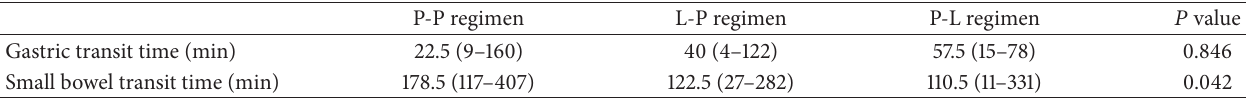
Table 2: Transit time of the capsule endoscope.